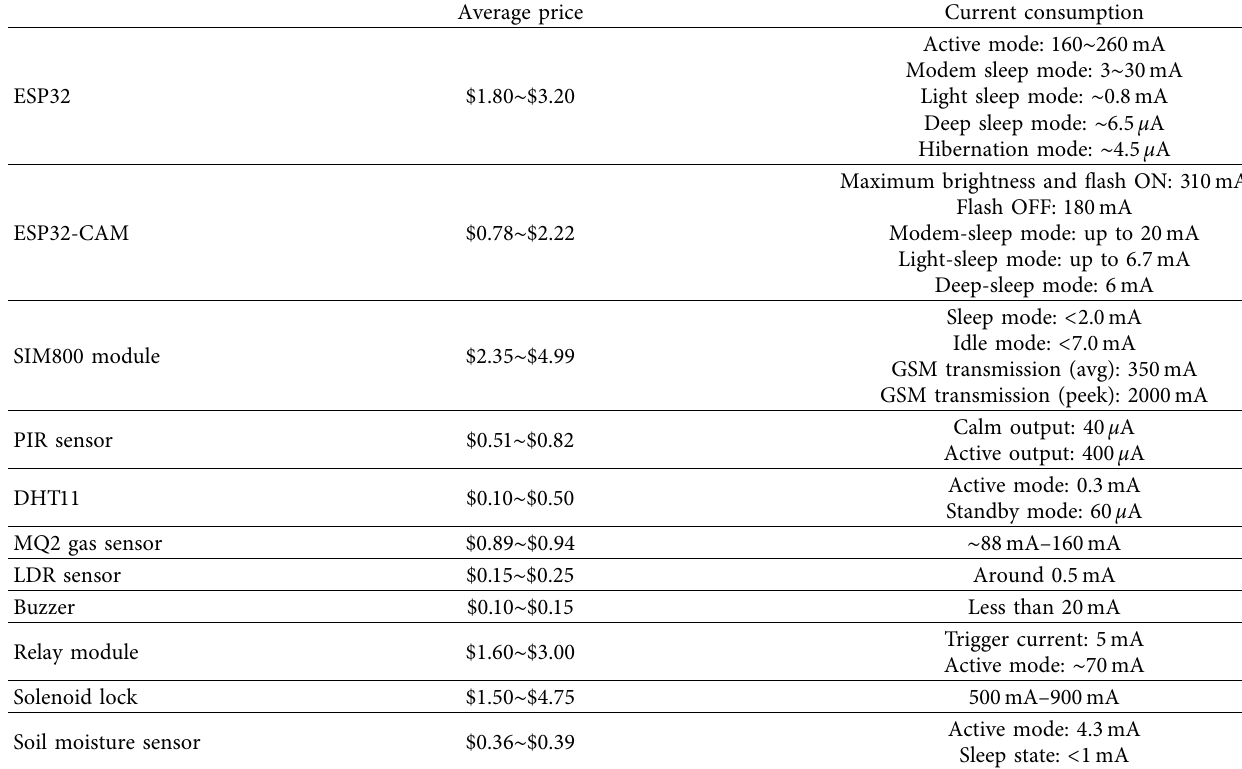
Table 2: Average price and current consumption of used